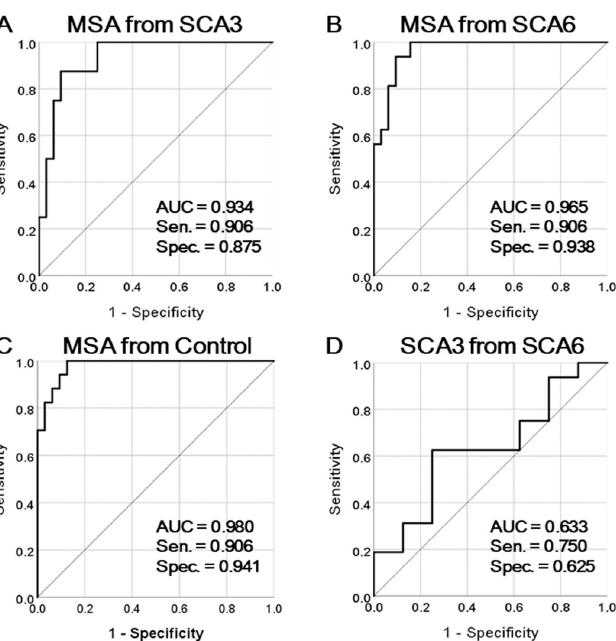
Fig 4. Receiver Operating (ROC) curves for the MCP sT1w/T2w ratio showing area under the curve (AUC), sensitivity (Sen), and specificity (Spec). A, B, and C are the ROC curves distinguishing cerebellar subtype multiple system atrophy (MSA-C) from spinocerebellar ataxia type 3 (SCA3) (A), spinocerebellar ataxia type 6 (SCA-6) (B), and controls (C). D is the ROC curve distinguishing SCA-3 from SCA-6. of the MCP sT1w/T2w ratio for differentiating MSA-C from SCA3, SCA6, and controls was comparable to or better than that of visual interpretation of MCP hyperintensities and the HCB sign for all three reviewers. However, the diagnostic performance of visual interpretation of MCP hyperintensities and the HCB sign for differentiating SCA3 from SCA6 was compara- ble to or better than that of the MCP sT1w/T2w ratio. The MCP volume, normalized by each subject’s intracranial volume, was significantly lower in patients with MSA-C patients than those in patients with SCA6 and controls (0.20 ± 0.06 vs. 0.31 ± 0.05 and 0.34 ± 0.05, respectively; p < 0.001). Moreover, the MCP vol- ume was significantly lower in patients with SCA3 than those in patients with SCA6 and con- trols (0.23 ± 0.04 vs. 0.31 ± 0.05 and 0.34 ± 0.05, respectively; p < 0.001; p = 0.01 and p < 0.001). The AUC value for differentiating MSA-C from SCA3 was 0.664 (95% CI, 0.486–0.842), with a sensitivity of 0.750 and specificity of 0.625. The AUC for differentiating MSA-C from SCA6 was 0.924 (95% CI, 0.852–0.995), with a sensitivity of 0.844 and specificity of 0.875. The AUC for differentiating MSA-C from controls was 0.967 (95% CI, 0.925–1.000), with a sensi- tivity of 0.906 and specificity of 0.941). The AUC for differentiating SCA3 from SCA6 was 0.914 (95% CI, 0.802–1.000), with a sensitivity of 0.875 and specificity of 0.875. The AUC of the MCP sT1w/T2w ratio was greater than that of the MCP volume for differentiating MSA-C from SCA3 ( p < 0.001). No significant differences were observed between the AUC of the MCP sT1w/T2w ratio and that of MCP volume for differentiating MSA-C from SCA6 and controls ( p = 0.234 and 0.577, respectively). The AUC of the MCP volume was greater than that of the MCP sT1w/T2w ratio for differentiating SCA3 from SCA6 ( p = 0.020). In patients with MSA-C, a significant correlation was observed between the MCP volume and MCP sT1W/T2W ratio ( r = 0.619; p < 0.001).